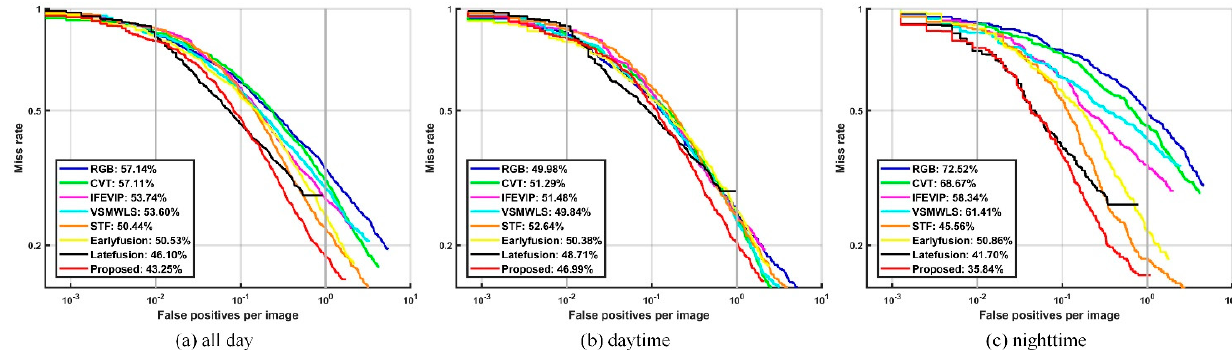
Figure 8. Quantitative comparison of the detection results via eight methods. ( a ) presents the results of all-day detection; ( b ) exhibits the results of daytime detection; ( c ) exhibits the results of nighttime